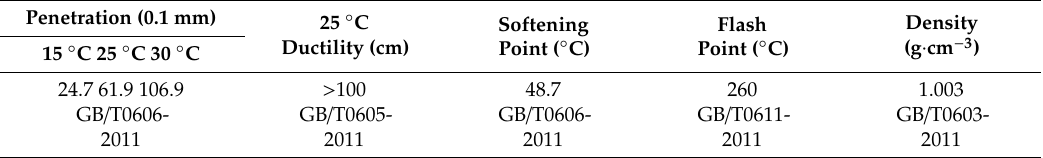
Table 1. Basic asphalt of technical